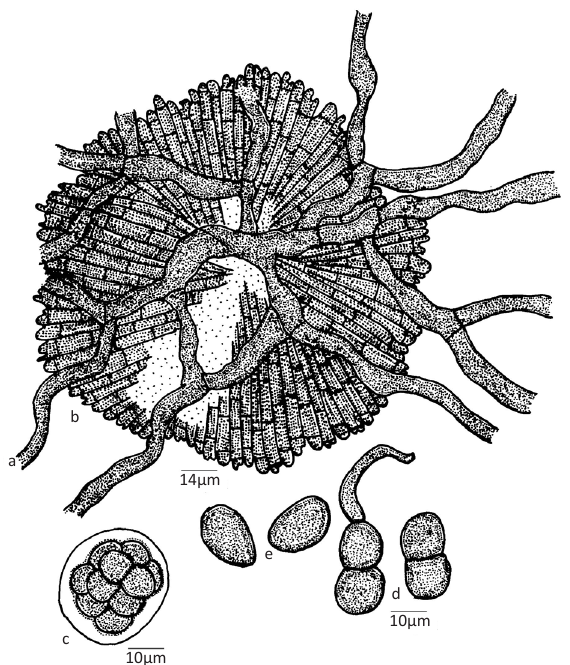
Figure 3. Prillieuxina pavettae sp. nov. a - Mycelium; b - Thyriothecium; c - Ascus; d - Ascospores; e - Pycnothyriospores